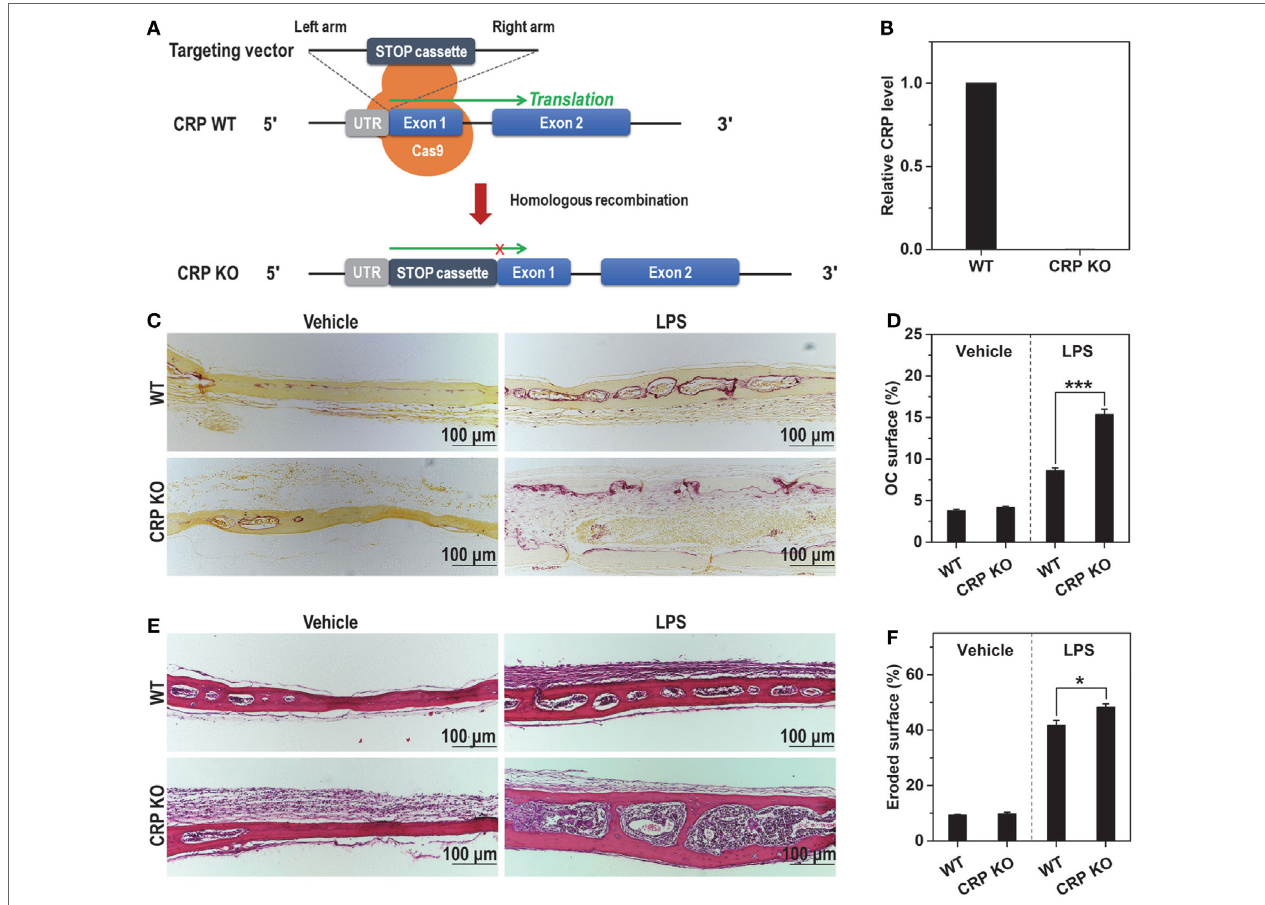
FigUre 5 | C-reactive protein (CRP) knockout (KO) aggravates proinflammatory bone damage in mice . (a) The design of CRP KO mice. (B) The mRNA level of CRP in liver tissues of wild-type (WT) and CRP KO mice. No CRP expression could be detected in CRP KO mice. LPS (5 mg/kg) or saline buffer (Vehicle) was s.c. injected on calvaria of healthy wild-type and CRP KO mice every 2 days for 1 week. TRAP (c,D) and hematoxylin and eosin staining (e,F) were conducted to evaluate osteoclastogenesis and bone damage, respectively. These pathological indices were aggravated in CRP KO versus wide type